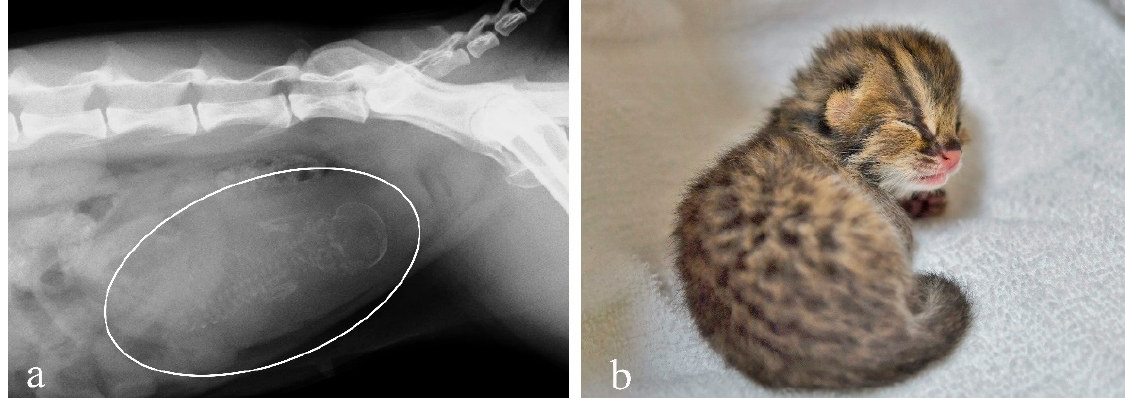
Figure 4. ( a ) Pregnancy diagnosis by radiography 51 days post-AI is confirmed by mineralized skeleton of a fetus (white circle). ( b ) Image of the Tsushima leopard cat kitten two days after birth.